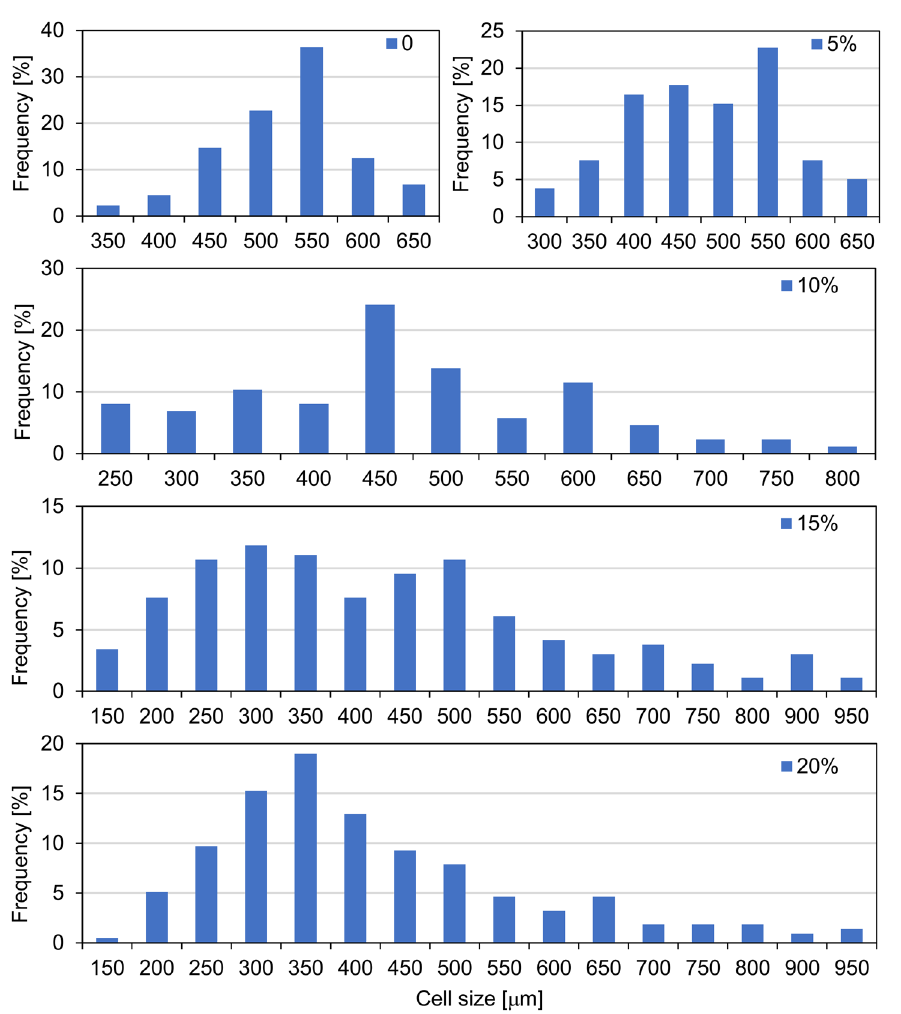
Figure 2. SEM images of PUR foam with different amounts of wood filler.